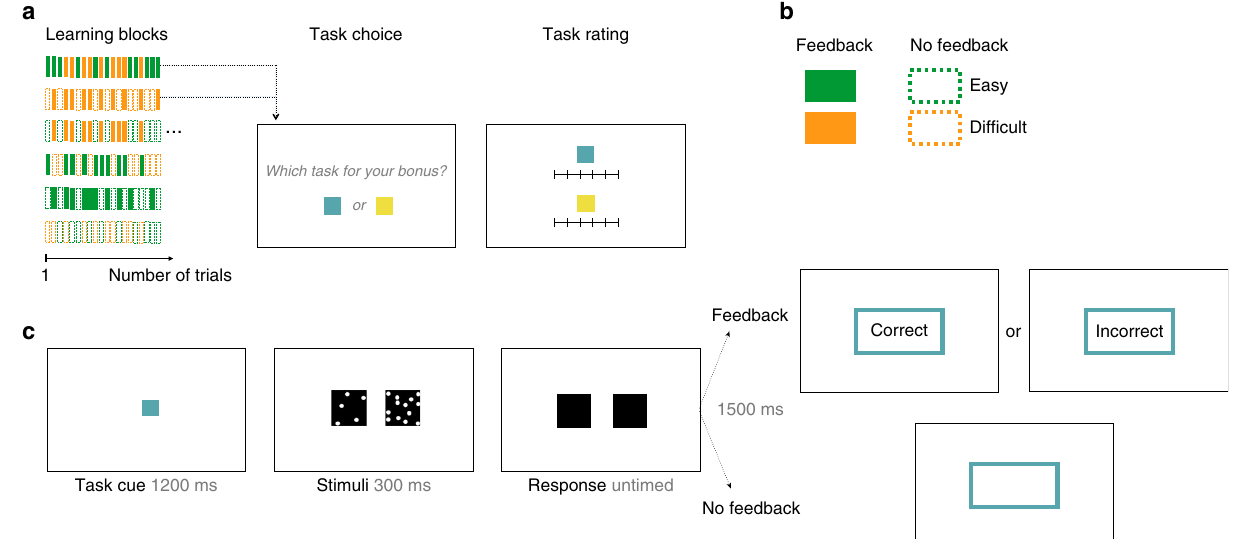
Fig. 1 Experimental design, Experiment 1. a Learning blocks were composed of randomly alternating trials from two “ tasks ” . Each task was either easy or dif fi cult and provided feedback or no feedback ( b ), resulting in six possible task pairings ( a ). At the end of each learning block, subjects were asked to choose which task should be used to calculate a monetary bonus based on their performance at the chosen task. They were also asked to rate their overall ability at each task on a continuous rating scale. A new block ensued with two new color cues indicating two new tasks. c Trial structure. Each trial consisted of a perceptual judgment as to which of two boxes contained a higher number of dots. Each judgment was either easy or dif fi cult according to the dot difference between the left and right boxes. Following their response, subjects either received veridical feedback (correct, incorrect) about